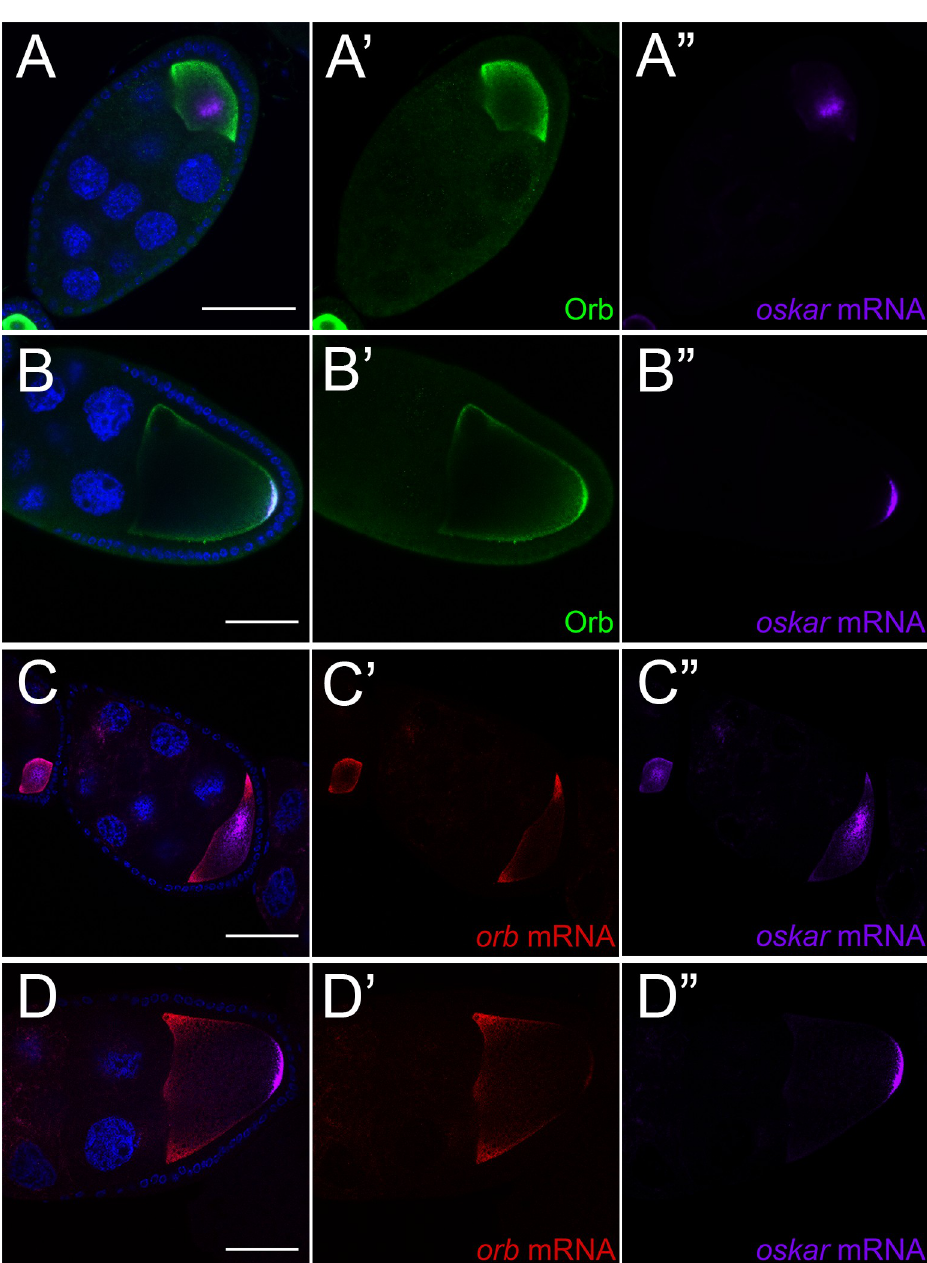
Fig 2. Orb protein and RNA do not colocalize with oskar mRNA during transport in wild type oocytes. (A) osk mRNA and Orb protein do not co-localize at stage 7. Orb protein is enriched subcortically (A’), while osk mRNA is enriched in the middle of the oocyte during transport (A”). (B) osk mRNA and Orb protein colocalize at the oocyte posterior at stage 9. (C) orb mRNA does not co-localize with oskar mRNA at stage 7. orb mRNA is enriched at the oocyte anterior (B’) while osk mRNA is enriched in the middle of the oocyte (B”). (D) orb mRNA does not co-localize with oskar mRNA at the posterior at stage 9. Instead, orb mRNA is localized along the oocyte anterior (D’), while osk mRNA is enriched at the posterior (D”). All scale bars 50